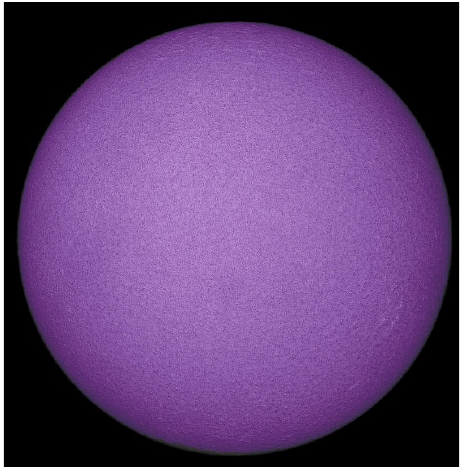
Figure 14. Lower Chromosphere seen via